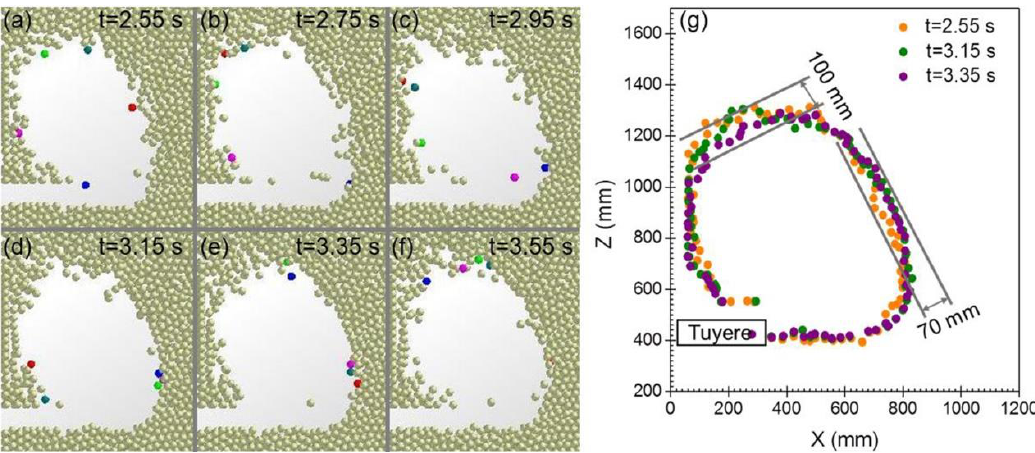
Figure 4. Void obtained in v inlet = 168 m/s at different times, i.e., ( a ) t = 2.55 s, ( b ) t = 2.75 s, ( c ) t = 2.95 s; ( d ) t = 3.15 s; ( e ) t = 3.35 s; ( f ) t = 3.55 s. ( g ) Particle position at the void boundary at t = 2.55 s, t = 3.15 s, t = 3.55 s.